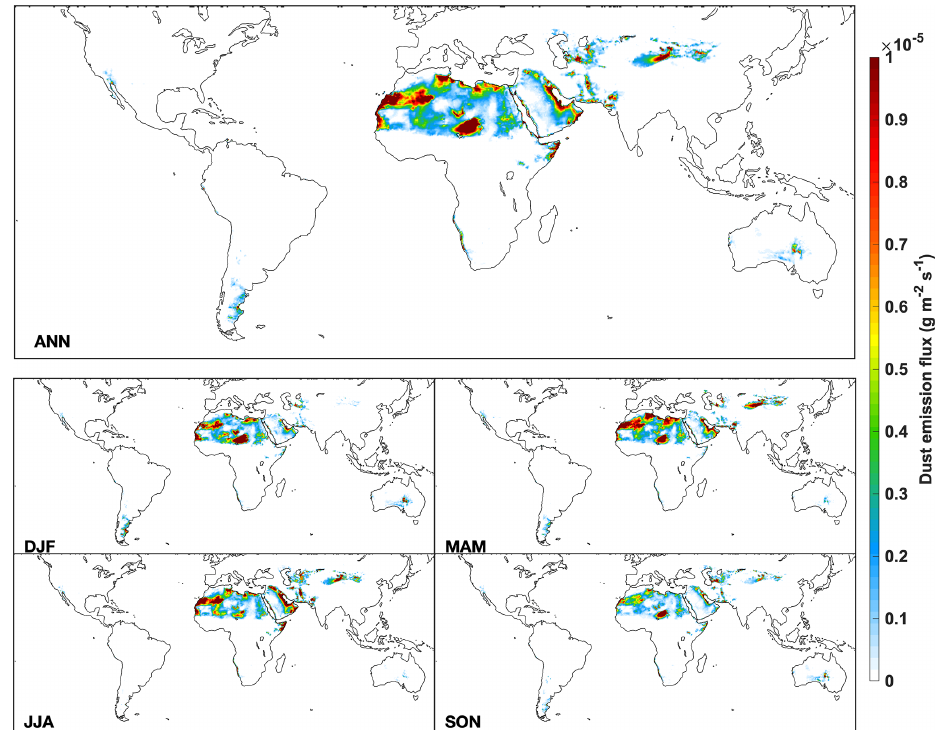
Figure 1. Annual and seasonal mean dust emission flux rate for the offline high-resolution dust emissions with updated dust source function and updated annual total dust emission of